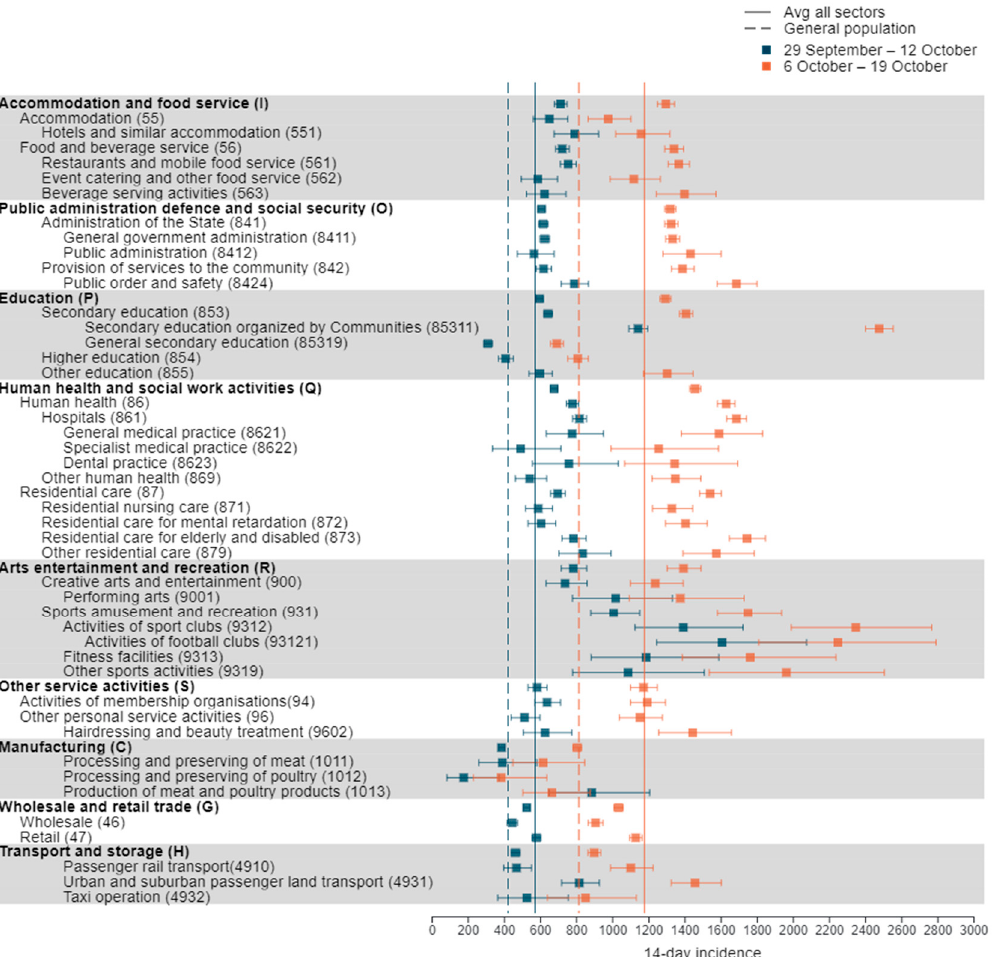
Figure 1. The 14-day incidence of COVID-19 in selected sectors in periods 29 September–12 October and 6–19 October.